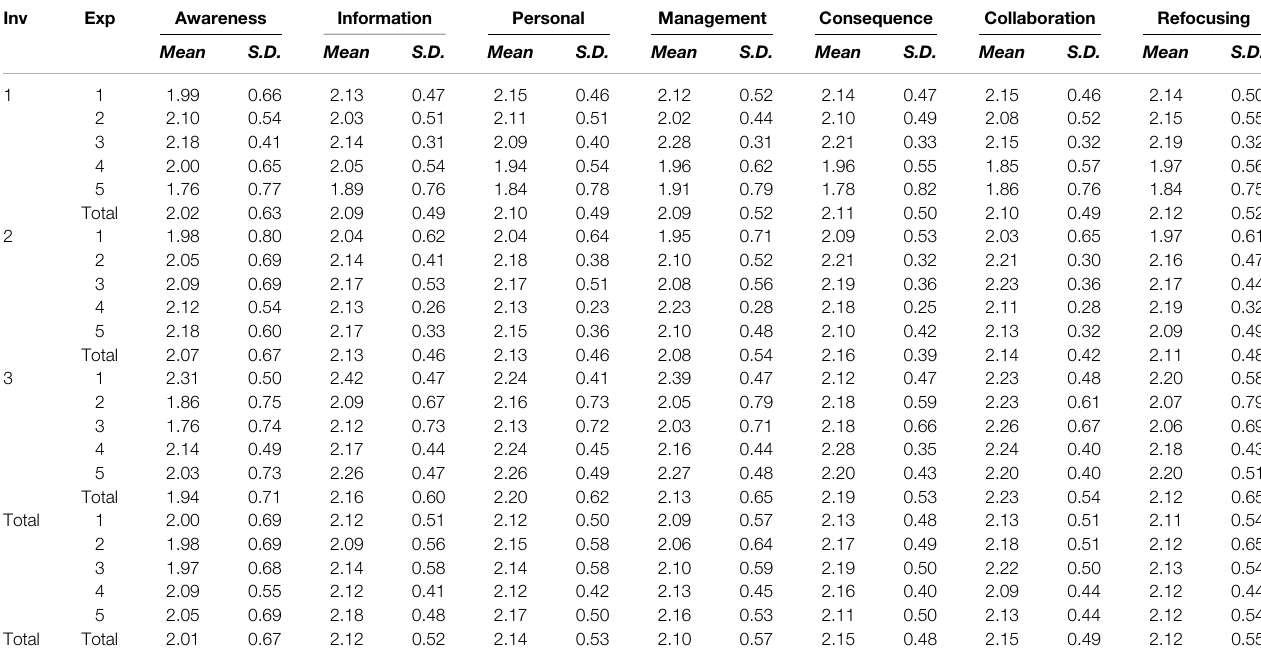
TABLE 5 | Means of SoC by teachers ’ experience and by teachers ’ years of involvement in the innovation. Inv